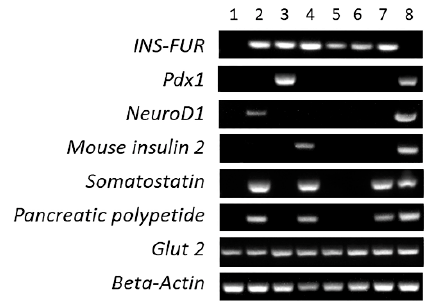
Figure 6. Expression of β -cell transcription factors and pancreatic hormones in the livers of transduced NOD mice. Standard end point (non-quantitative RT-PCR) analysis was conducted from RNA derived from liver tissues of the NOD mice to detect the expression of INS-FUR , Pdx1, NeuroD1, mouse insulin 2, mouse somatostatin, pancreatic polypeptide, Glut 2 , and beta-actin (positive control) in normal mouse liver (lane 1), liver tissue from diabetic NOD mice expressing INS-FUR via i.p. injection of AAV8- INS-FUR -mCherry (lane 2), INS-FUR and Pdx1 via i.p. injection of AAV8- INS-FUR -venus + AAV8- Pdx1 (lane 3), AAV8- INS-FUR -venus + FFO surgery (lane 4), via i.p. injection of AAV8- INS-FUR -venus + HMD / MSCV-EGFP via the portal vein (lane 5), AAV8 / piggyBac - INS-FUR -mCherry (lane 6), AAV8 / piggyBac - INS-FUR -mCherry + FFO surgery (lane 7) and normal mouse pancreas (lane